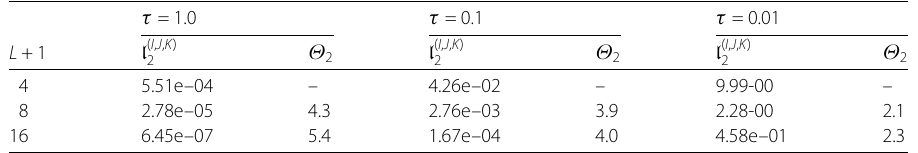
Table 1e Errors and order for UM-FOCS in Example 5.1